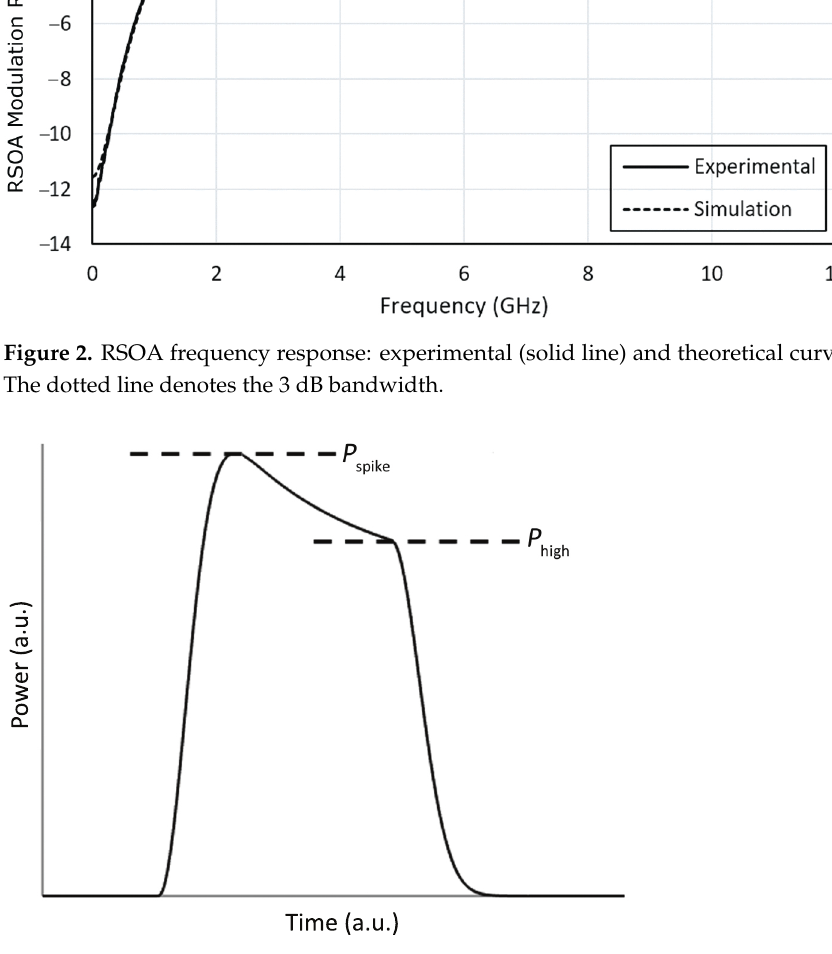
Figure 3. Overshoot definition and effect on amplified pulse